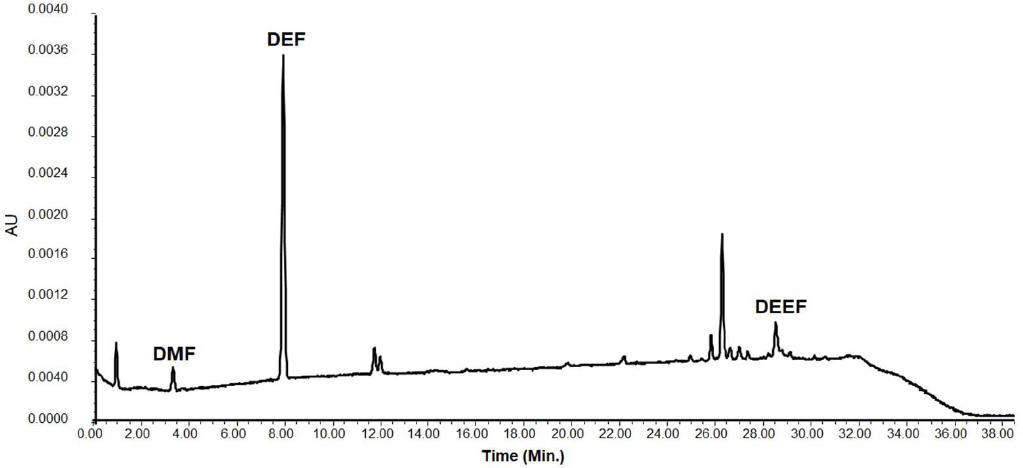
Figure 7. Bottled water sample extract subjected to the proposed SPE-HPLC-PDA